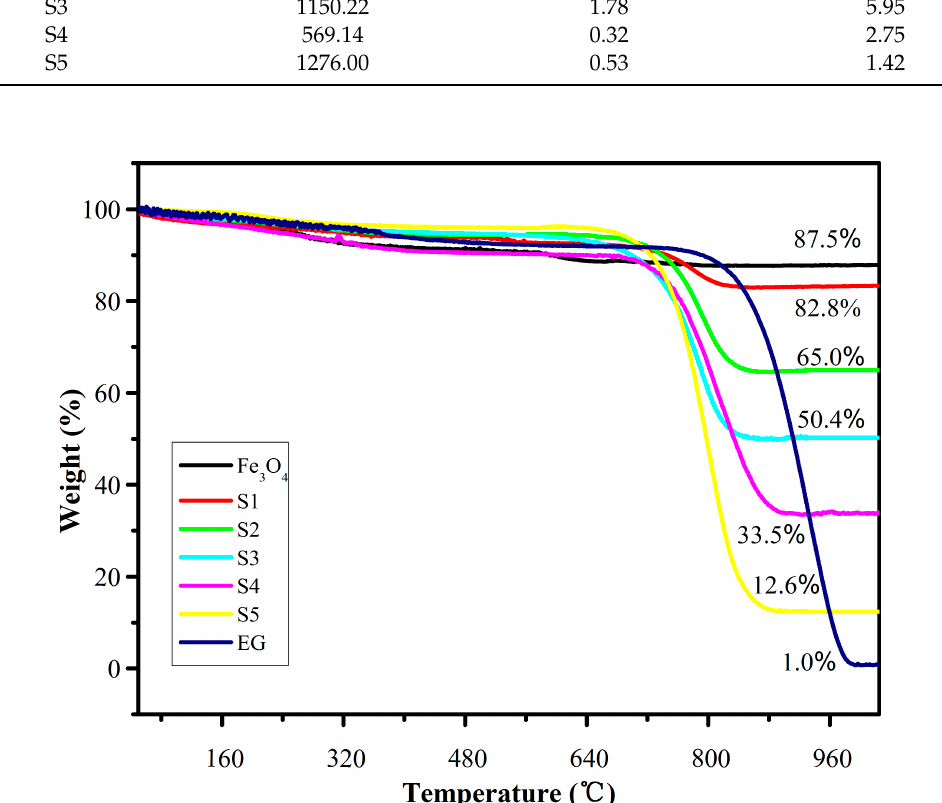
Figure 8. Thermogravimetric (TG) curves of Fe 3 O 4 and composites S1–S5 under air atmosphere.